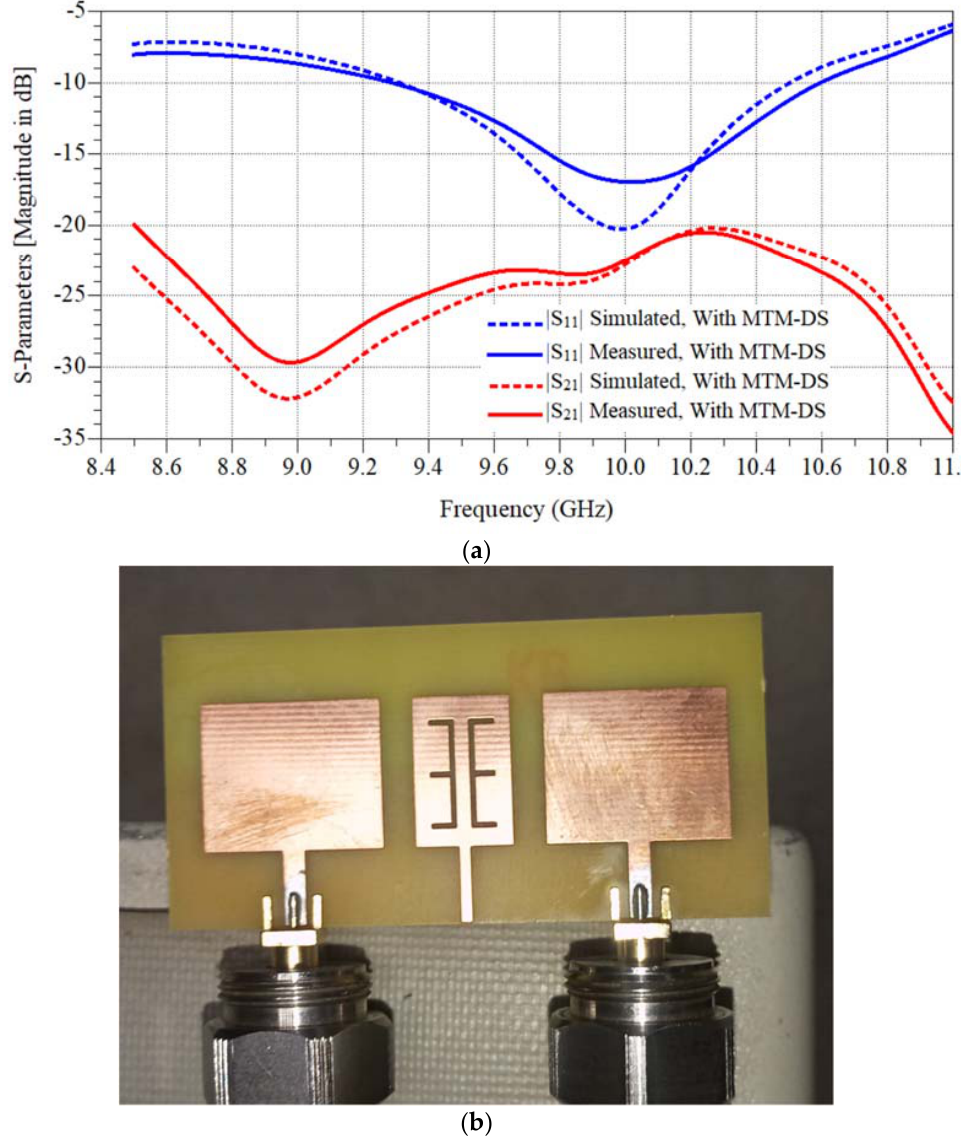
Figure 6. The fabricated 2 × 1 antenna microstrip patch antenna array with MTM-DS. ( a ) Simulated and measured S-parameters results. ( b ) Connected antenna array photo with decoupling slab.